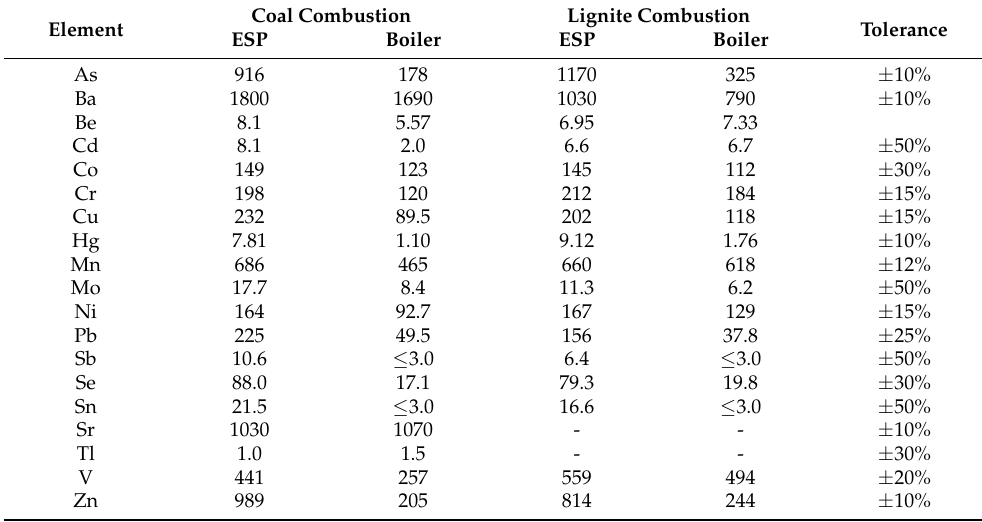
Table 6. Minor elements of fly ash chemical composition